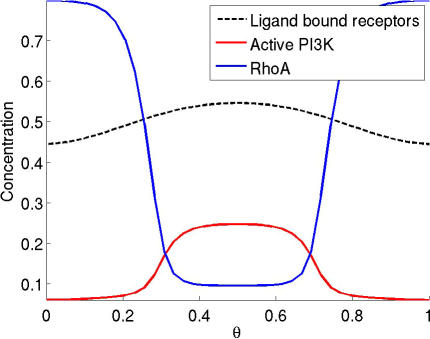
Mechanism for PolarizationReceptor–chemoattractant complexes (black dashed) sharply localize activated PI3K (red) to the front via the PI3K/Ras coincidence circuit. Activated PI3K localizes actin (not shown) which inhibits RhoA (blue) from localizing to the front. The abscissa (θ) is the location on the cell periphery. Chemoattractant concentration on the surface of the cell was specified by the function L(θ) = 1 − 0.25 cos(2πθ).